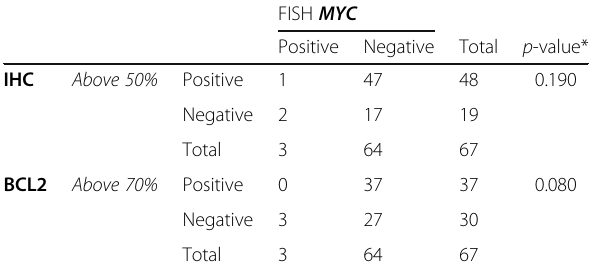
Table 3 Association between the positivity for BCL2 in the immunohistochemistry (IHC) and detection of MYC rearrangement by FISH: comparison between 50% cut-off and 70% cut-off for BCL2